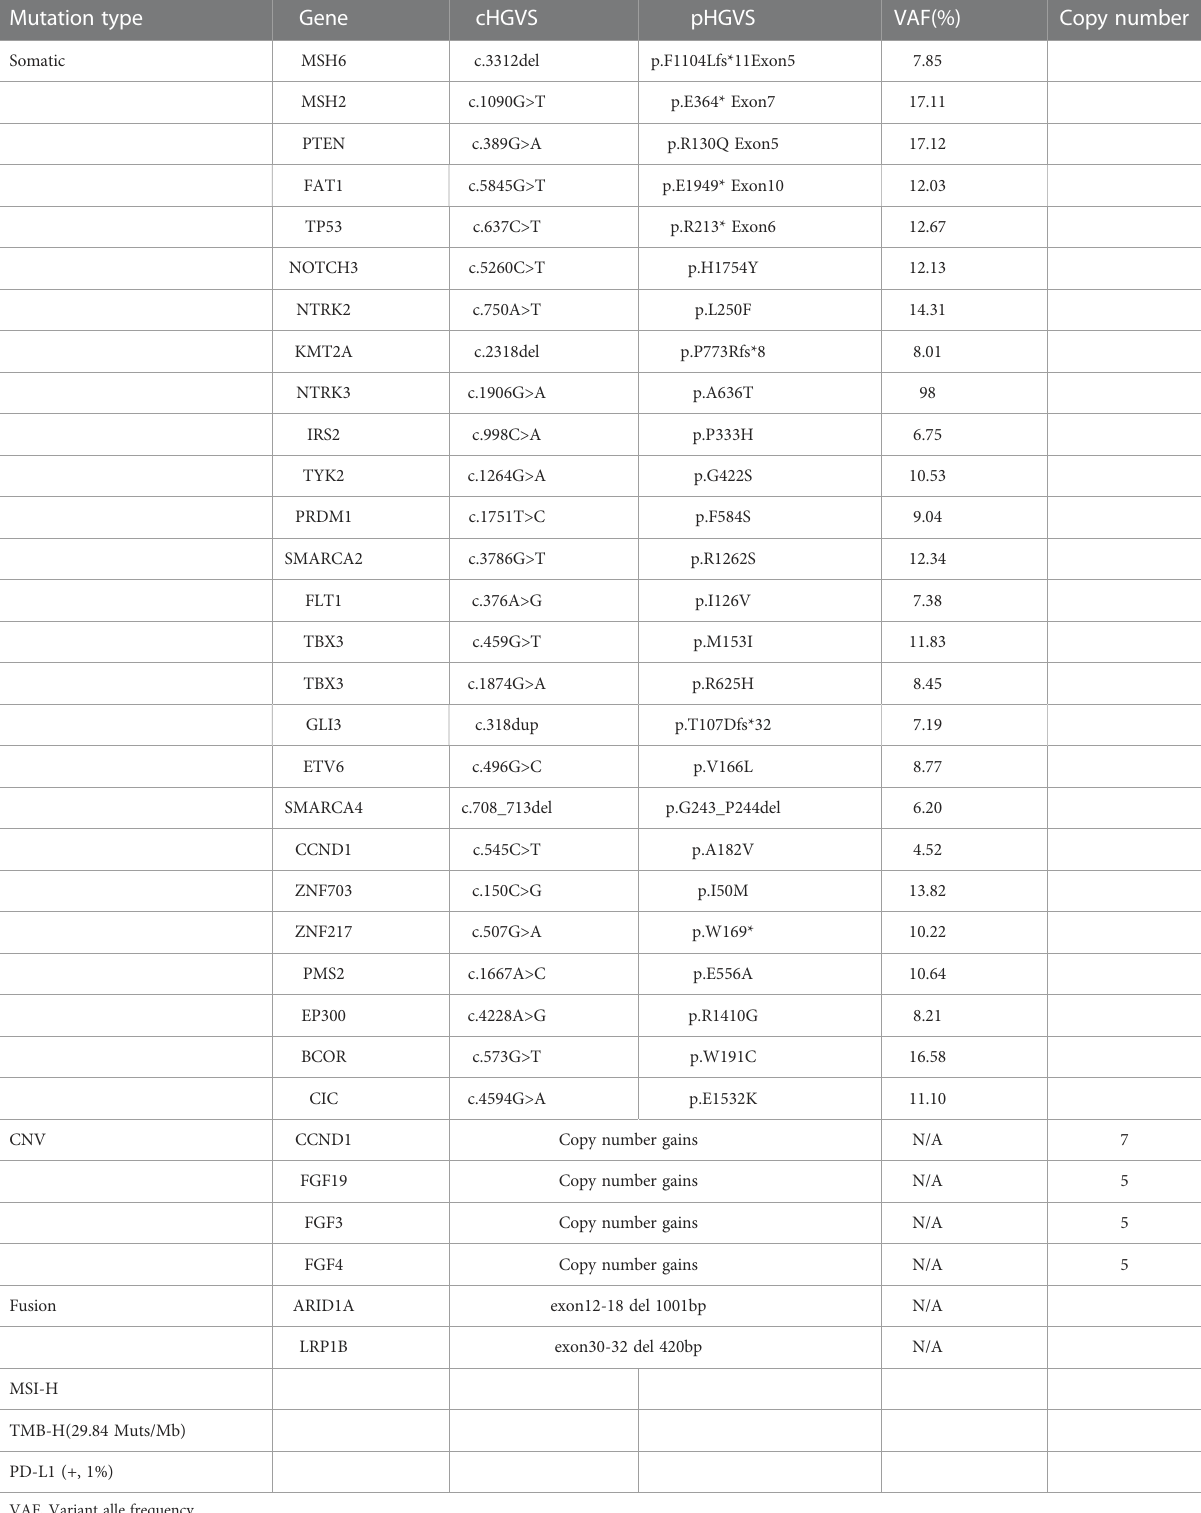
TABLE 1 Somatic testing